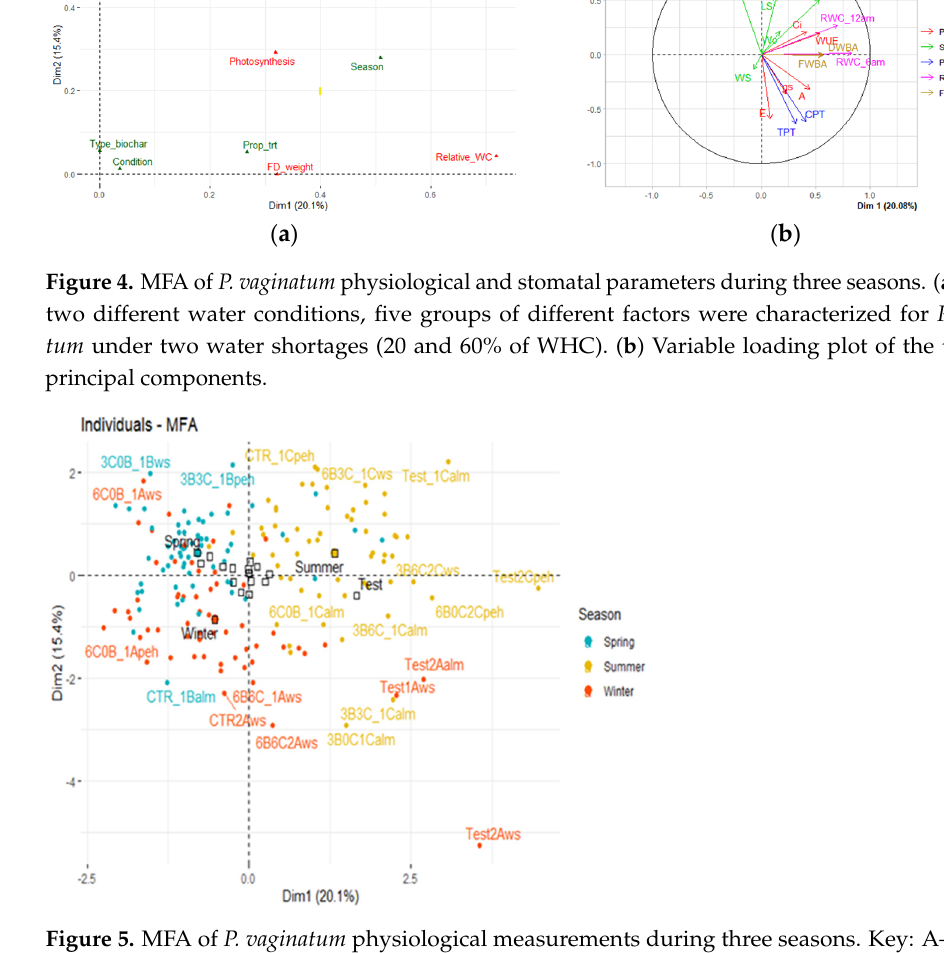
Figure 5. MFA of P. vaginatum physiological measurements during three seasons. Key: A—winter season, B—spring season, C—summer season, 1—60% WHC, 2—20% WHC; ws—walnut shells bi-